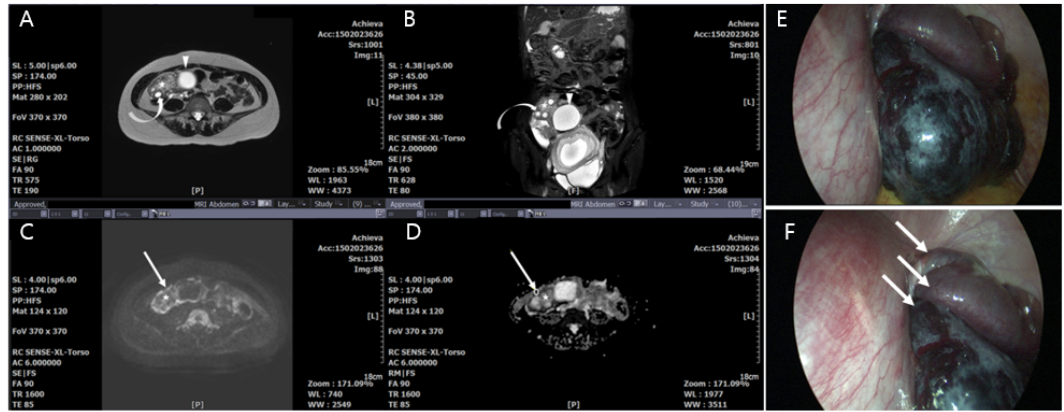
Figure 6. A 31-year-old pregnant woman (11 weeks) with acute adnexal torsion with hemorrhagic infarction in a salpingo-oophorectomy group. ( A ), ( B ) Tranaxial and sagittal T2-weighted single-shot turbo spin-echo MR images show hyperintense swollen ovarian medullary stroma (star) and prominent cortical follicles (curved arrow). A 4.5 cm sized unilocular cystic mass (arrowhead) was pathologically diagnosed as a corpus luteal cyst. ( C ) Transaxial diffusion-weighted MR image shows the hyperintense cortex (arrow) and heterogenous hyperintense swollen ovarian medulla (star). ( D ) Apparent diffuse coefficient (ADC) value indicating the region of interest (ROI) was 1.97 ± 0.11 × 10 −3 mm 2 /s in the ovarian medulla (star), and 0.47 ± 0.05 × 10 −3 mm 2 in the ovarian cortex (circle), respectively ( E ) and ( F ) Gross appearance of the ovarian pedicle with 1080° torsion (arrows) under laparoscopy.